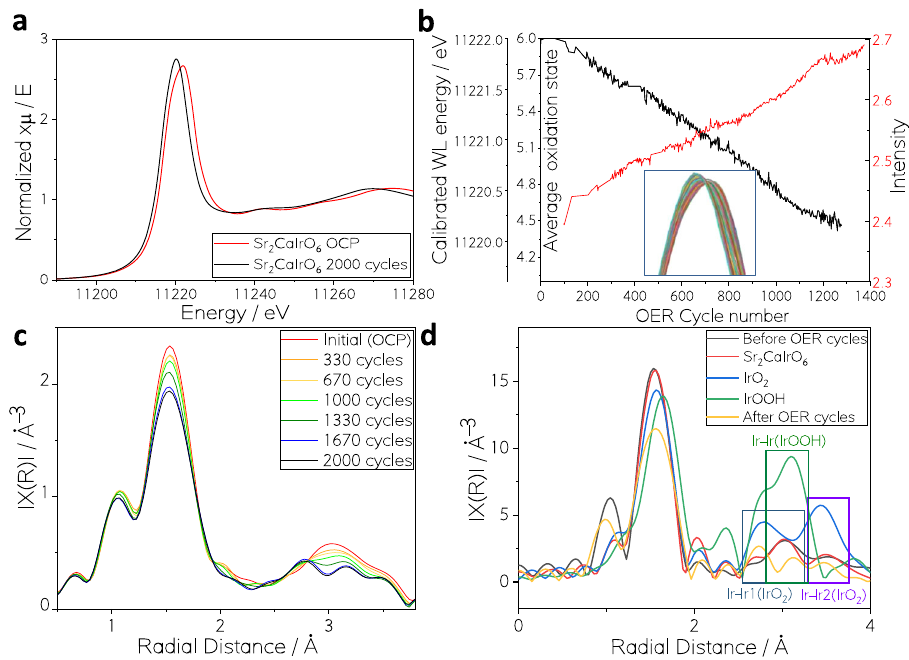
Fig. 4 | In situ monitoring of the catalyst evolution during the OER. a XANES signals of the Ir L 3 -edge of Sr 2 CaIrO 6 -Elec, Sr 2 CaIrO 6 − 2000, and IrO 2 standard. b Evolutionofthewhitelineposition,relatedtotheevolutionoftheoxidationstate (black) and the intensity (red) of the XANESsignal around 11220eV during cycling. Inset: Zoom on white line position and intensity changes of the XANES